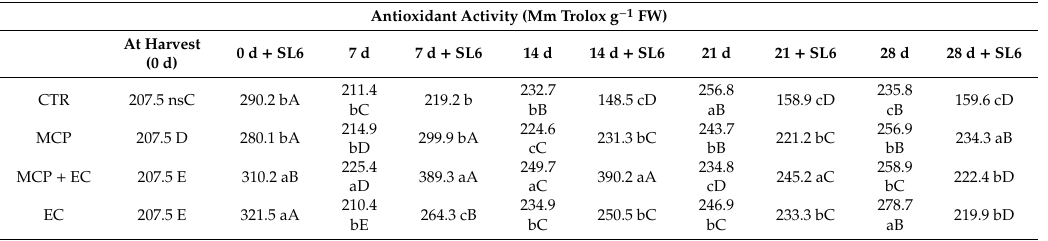
Table 5. Total antioxidant activity (TAA, expressed as Trolox equivalents (Mm Trolox) per 100 g fresh weight (FW) of juices of di ff erent treatment (CTR, MCP, MCP + EC, and EC) and stage (days) determined by the ABTS assay.